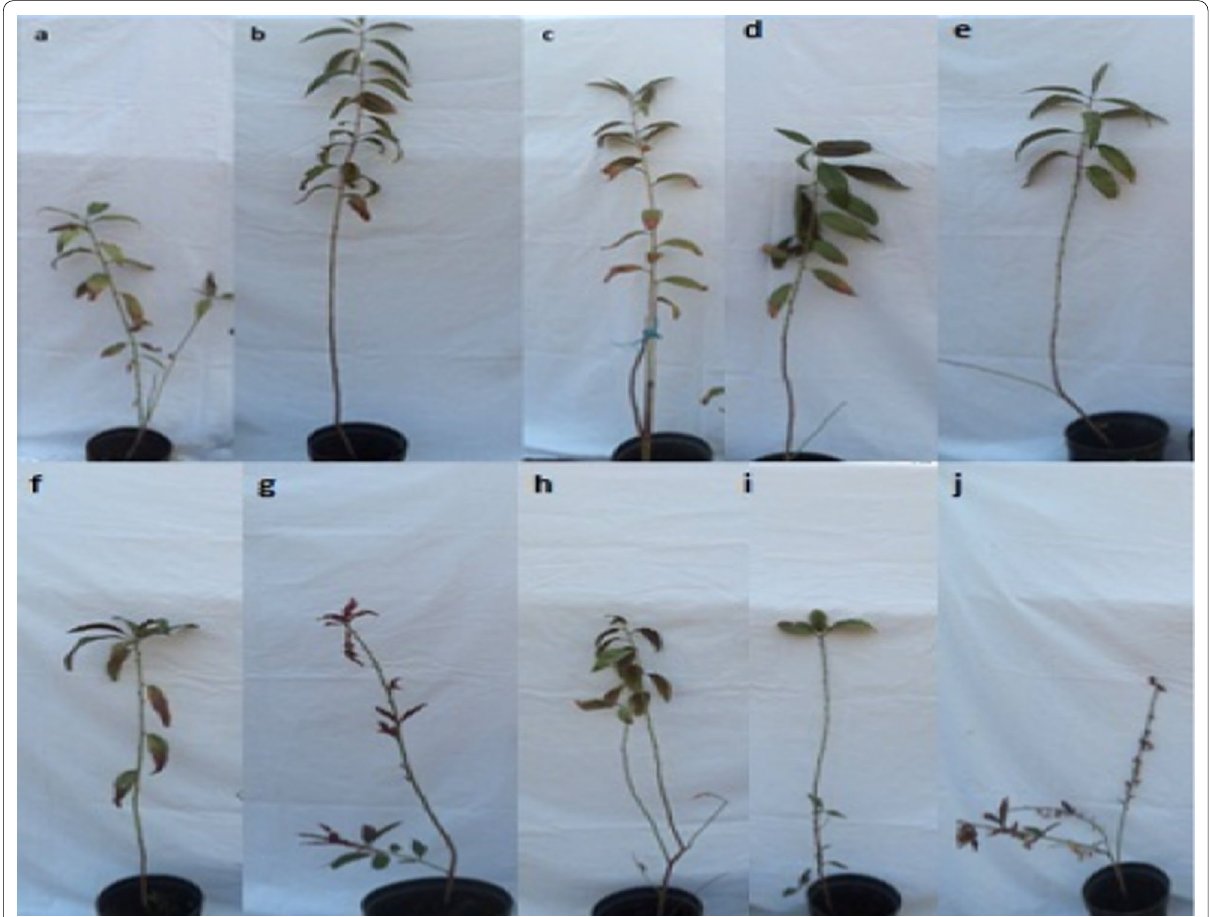
Fig. 3 Peach plants recorded three months after inoculation with Pythium ultimum and their treatment: inoculated control ( a ), Aspergillus niger A10 ( b ), Bacillus subtilis (B) ( c ), Trichoderma harzianum T9 ( d ), uninoculated control ( e ), A. candidus A5 harzianum